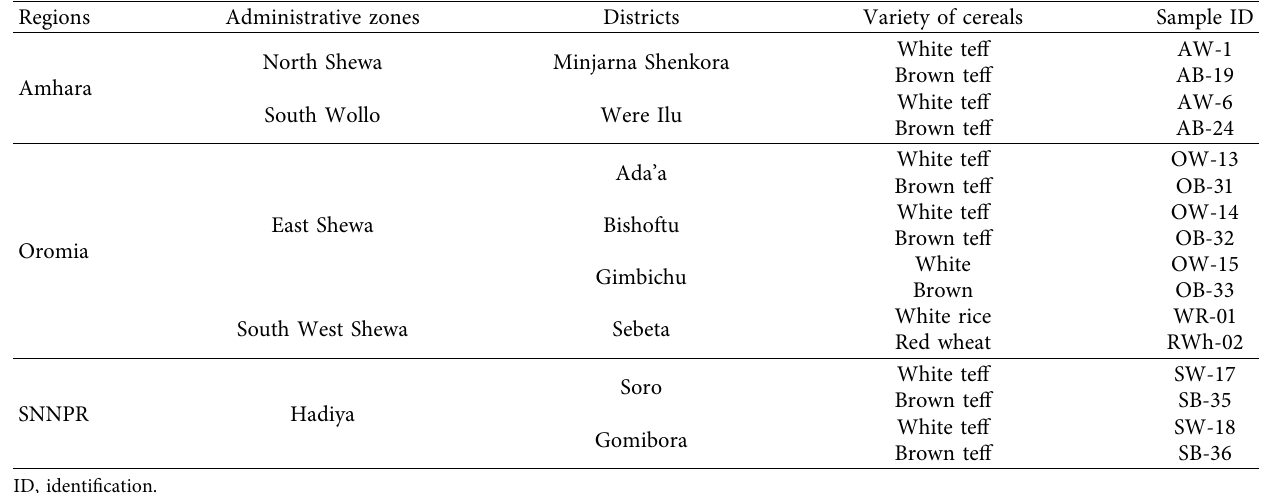
Table 1: Sampling areas and sample ID of the white and brown tef grains ( Eragrostis tef (Zuccagni) Trotter), white rice, and red wheat varieties cultivated in Ethiopia.